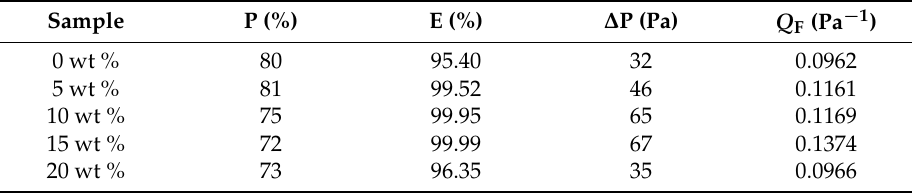
Figure 6. Pore distribution of sc -PLA/PMMA nanofiber filter with different sc -PLA contents. Table 1. Performance summary of different air filters.